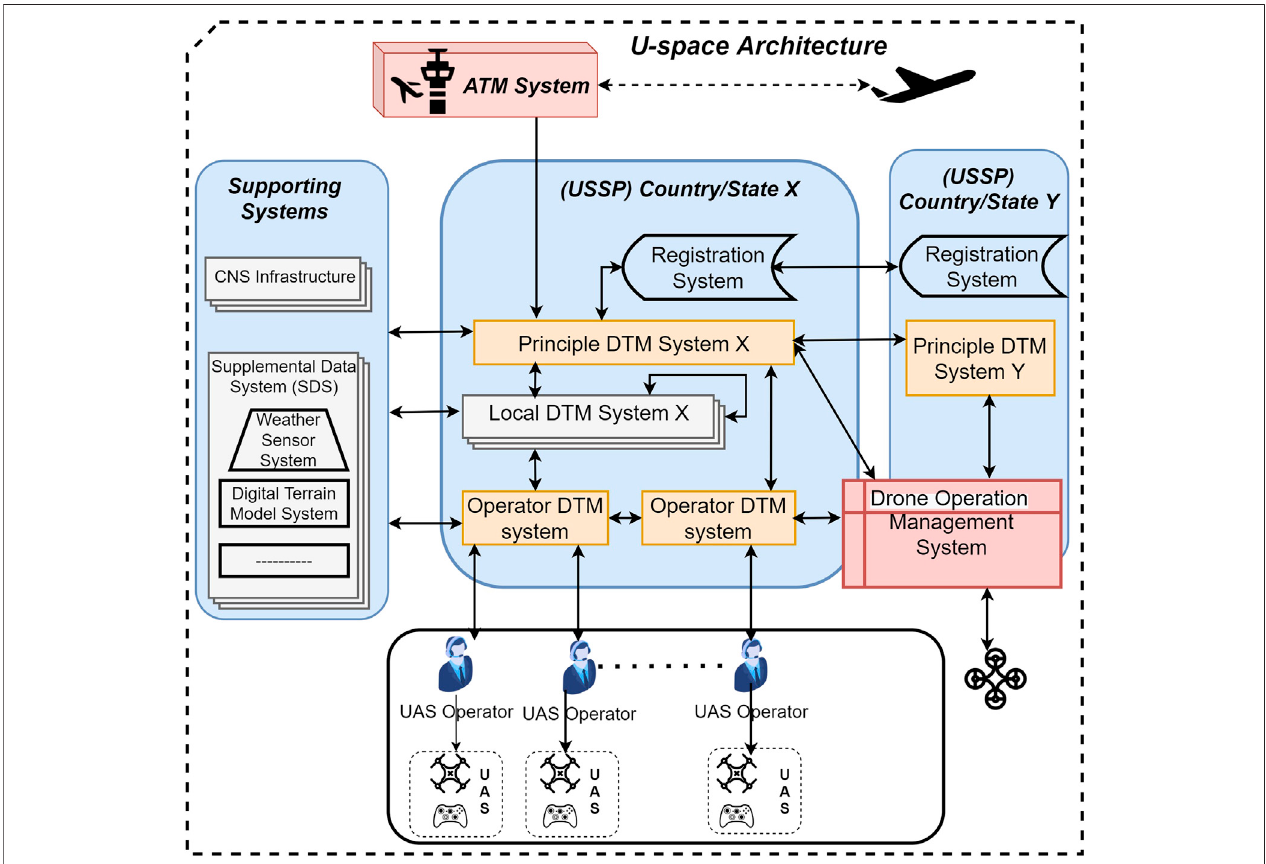
FIGURE 5 | EU U-space